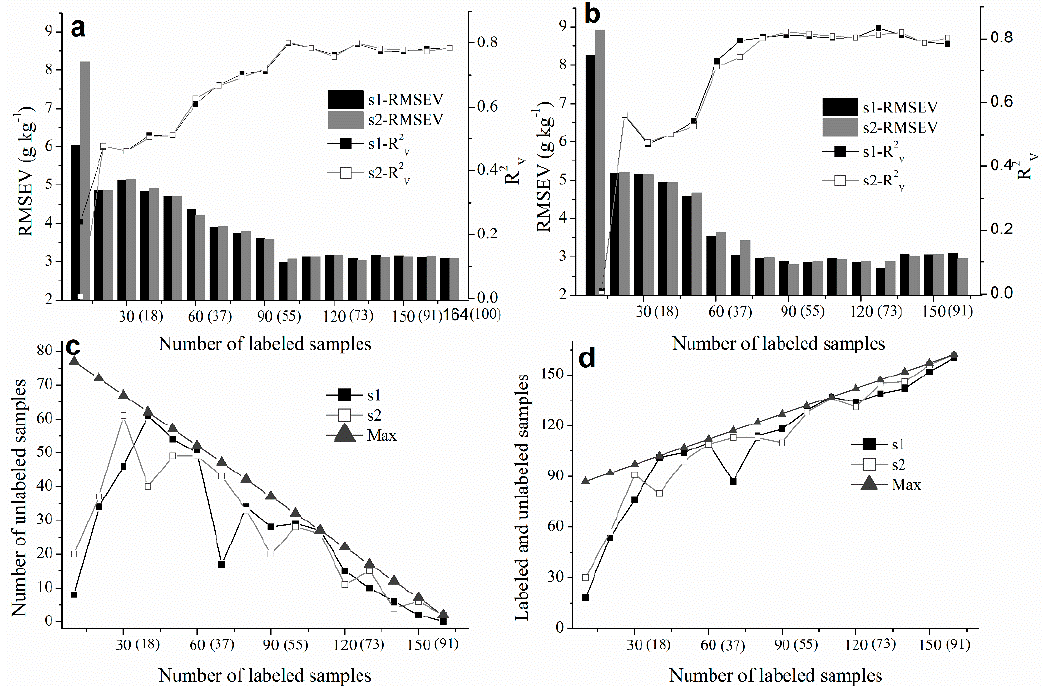
Figure 7. The performances of the two models trained only with labeled samples ( a ); and the refined models of Co-LSSVMR ( b ); the number of unlabeled samples used in each refined model ( c ); and total number of labeled and unlabeled samples used in each refined model ( d ) versus the number of labeled samples and its percentage (in brackets). The “Max” in ( c ) indicates the maximum number of unlabeled samples available for each regressor, which is one half of the pool size of unlabeled samples, and the “Max” in ( d ) indicates the maximum total number of labeled and unlabeled samples available for each regressor.